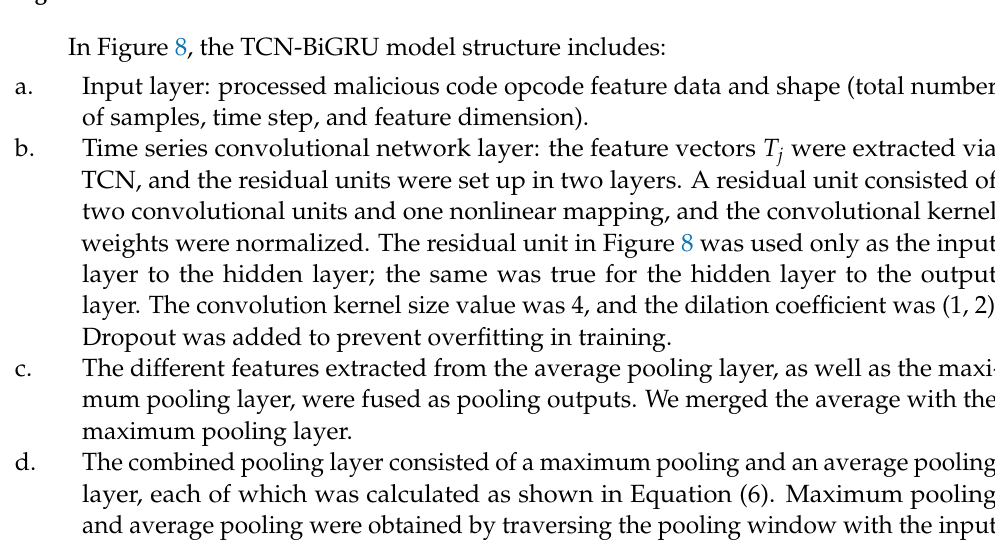
Figure 8. TCN-BiGRU